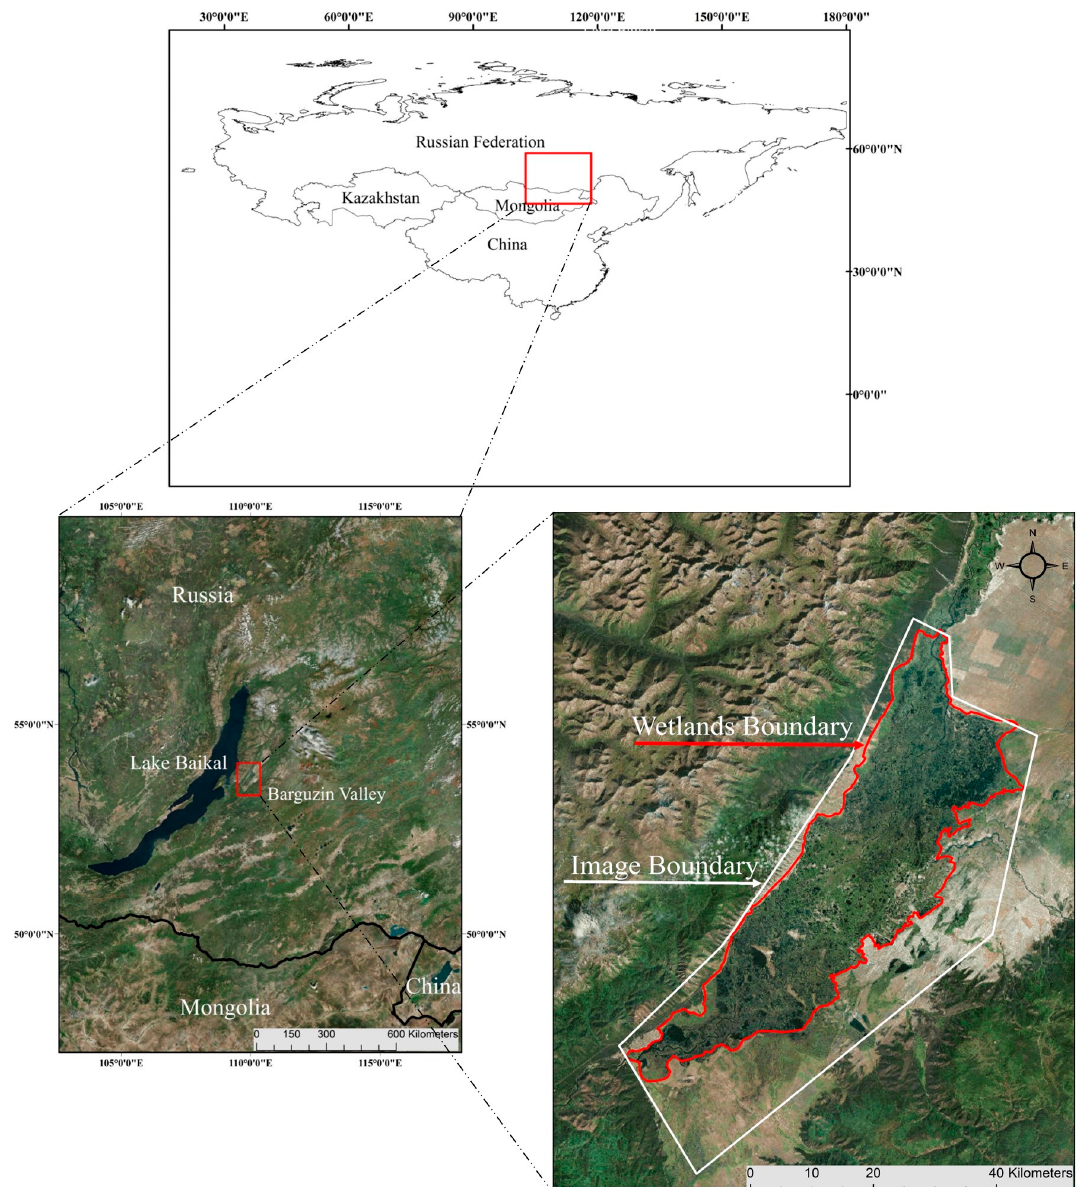
Figure 1. Location of Lake Baikal and the lower Barguzin Valley study area and Quickbird imagery boundary.